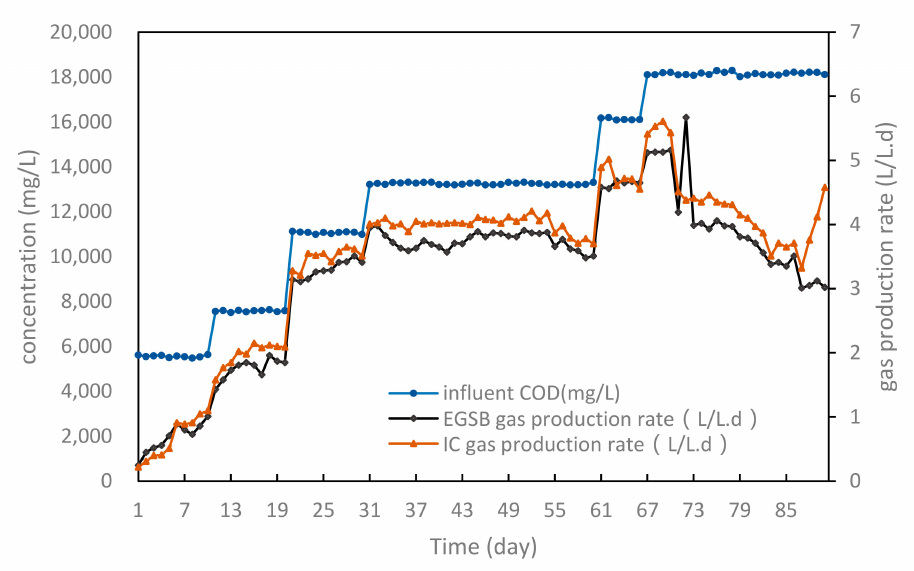
Figure 9. Influence of influent COD concentration on gas production rate.